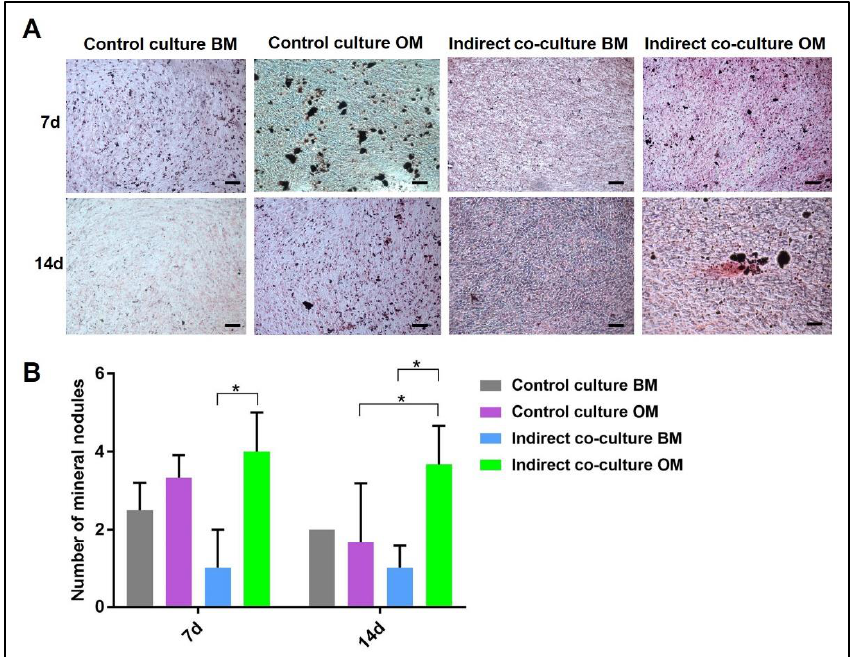
Figure 7. Quantification of mineral nodules deposited by OBs after von Kossa staining of single-cultures (control culture) and indirect co-cultures exposed to basal medium (BM) or osteogenic medium (OM) for 7 and 14 day. In ( A ) representative fields of samples stained with von Kossa and in ( B ) the diagram of the data collected (* p - value ≤ 0.05). Scale bar: 100 µm. Tartrate-resistant acid phosphatase (TRAP) and phalloidin-fluorescein isothiocyanate (FITC) stainings performed on PBMCs derived from the indirect OBs/PBMCs co-culture are shown in Figure 8 and Figure 9, while on PBMCs from the the control culture in Figure 10 and Figure 11, respectively.